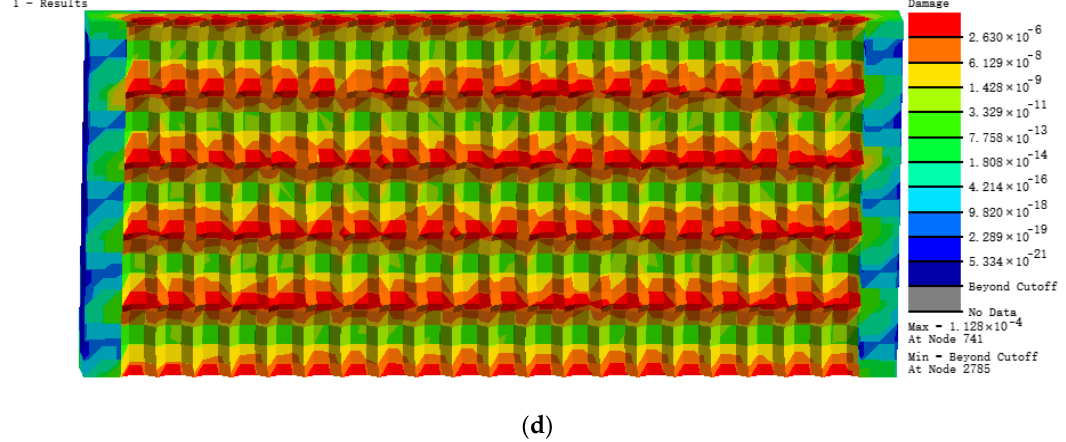
Figure 15. Nephograms of fatigue damage. ( a ) S1 model; ( b ) S2 model; ( c ) S3 model; ( d ) S4 model.